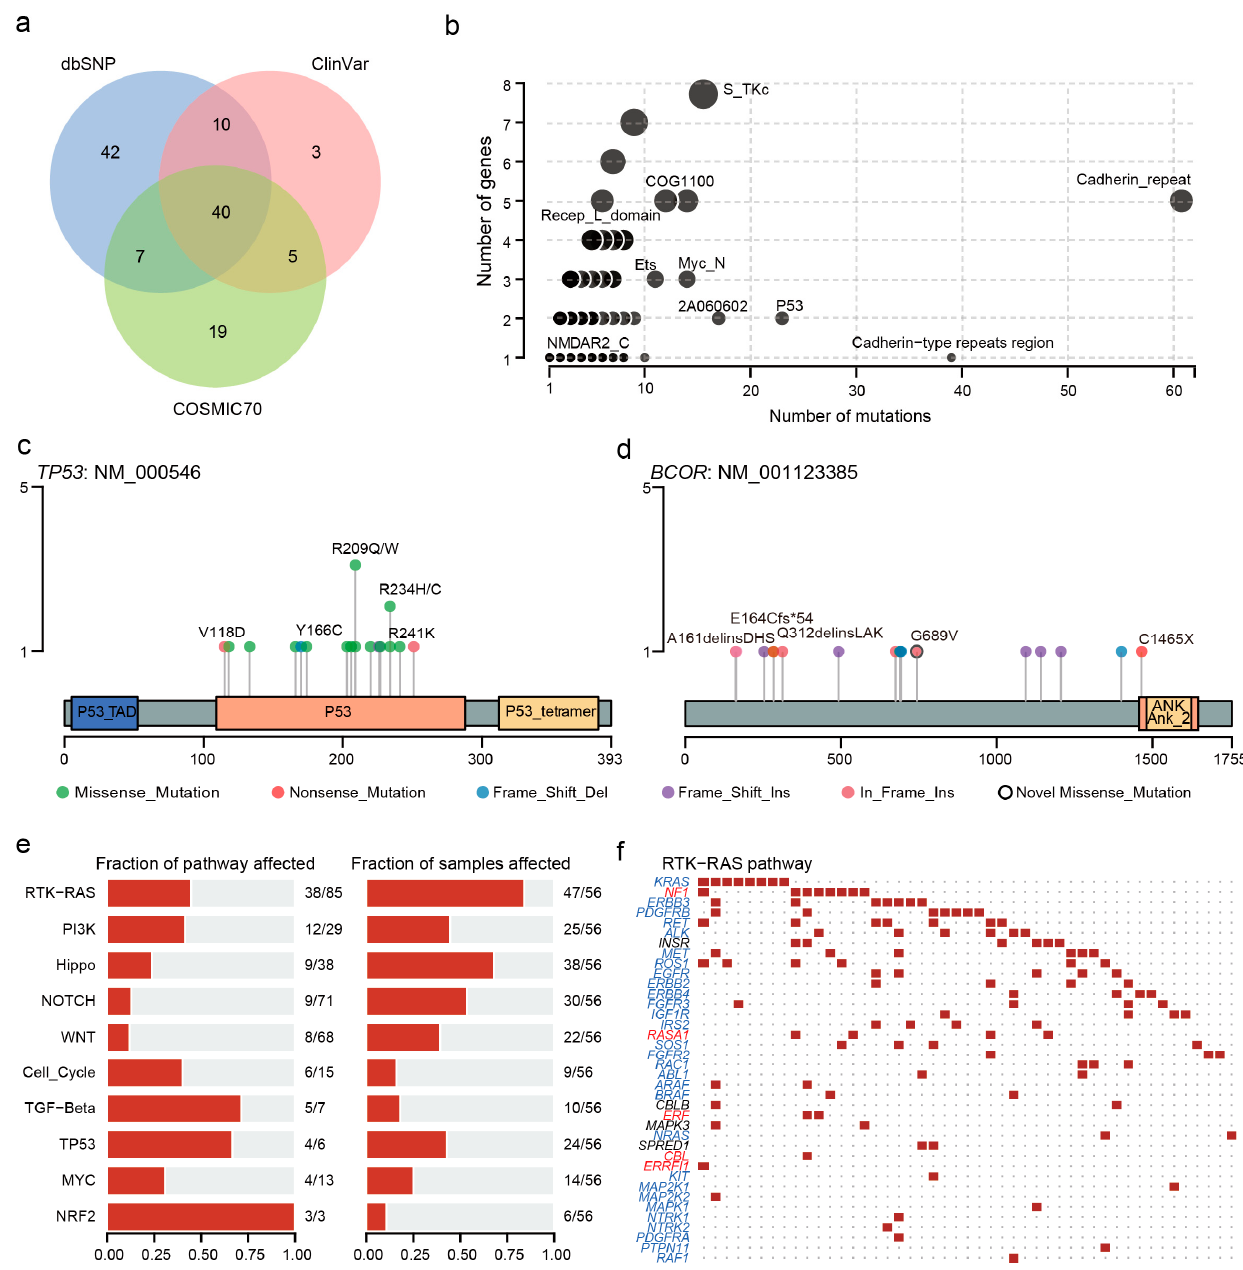
Figure 3. Clinical implications of mutations and domain and pathway enrichment analysis. ( a ) Venn plot of database–registered variants. ( b ) Frequently mutated pfam protein domains in CCA. The size of the bubble is in proportion to the number of genes containing prominent display domains. ( c ) Location of TP53 mutations schematic. ( d ) Location of the BCOR mutations schematic. ( e ) Enrichment of known oncogenic signaling pathways. ( f ) Mutated genes in the RTK-RAS pathway. Tumor suppressor genes are in red, and oncogenes are in blue font. The red square represents a patient with one or more mutations in this gene and the black dot represents no mutation detected in the